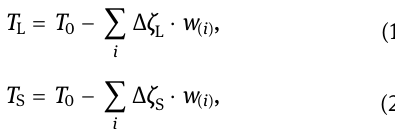
Table 1: Chemical composition of analyzed U75V heavy rail steel ( mass% )